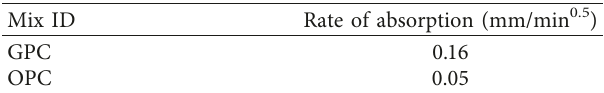
Figure 15: Regression analysis-absorption versus square root of time for (a) GPC and (b) OPC. Table 10: Rate of absorption (Sorptivity) values for different concrete